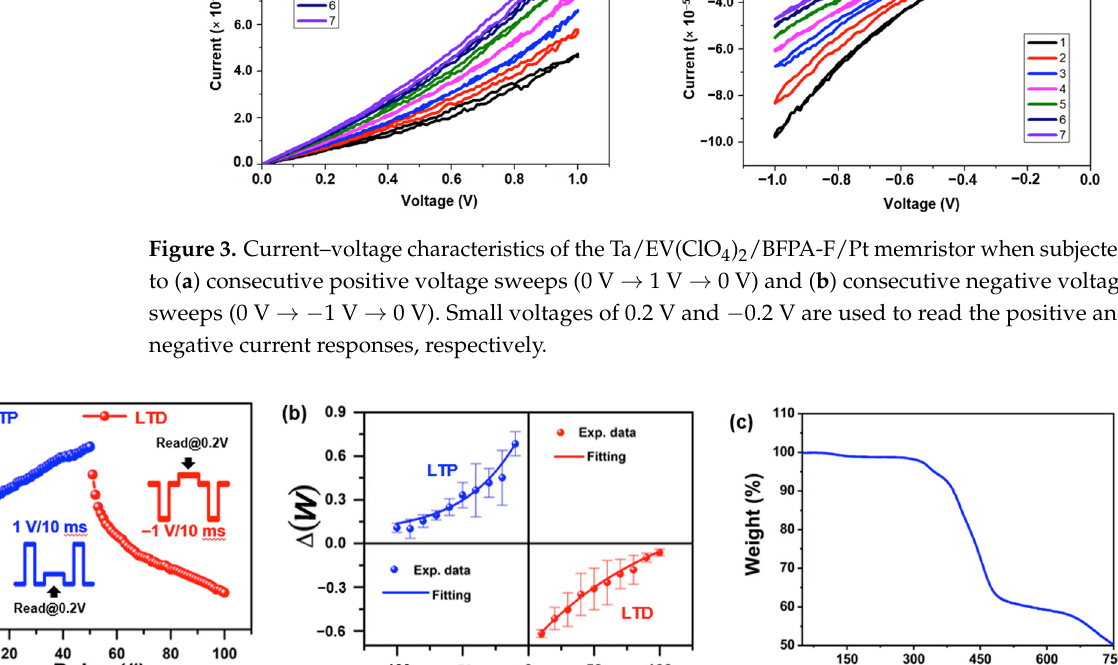
Figure 4. Long-term synaptic plasticity of the Ta/EV(ClO 4 ) 2 /BTPA-F/Pt memristor. ( a ) Long-term potentiation and depression characteristics by applying rapid and repetitive positive and negative voltage pulses to the device. A small voltages of ± 0.2 V are used to read the current responses and calculating the corresponding conductance. ( b ) Schematic illustration of the spike-timing-dependent plasticity properties of the device. ( c ) Synaptic weight retention performance of the device in response to temperature